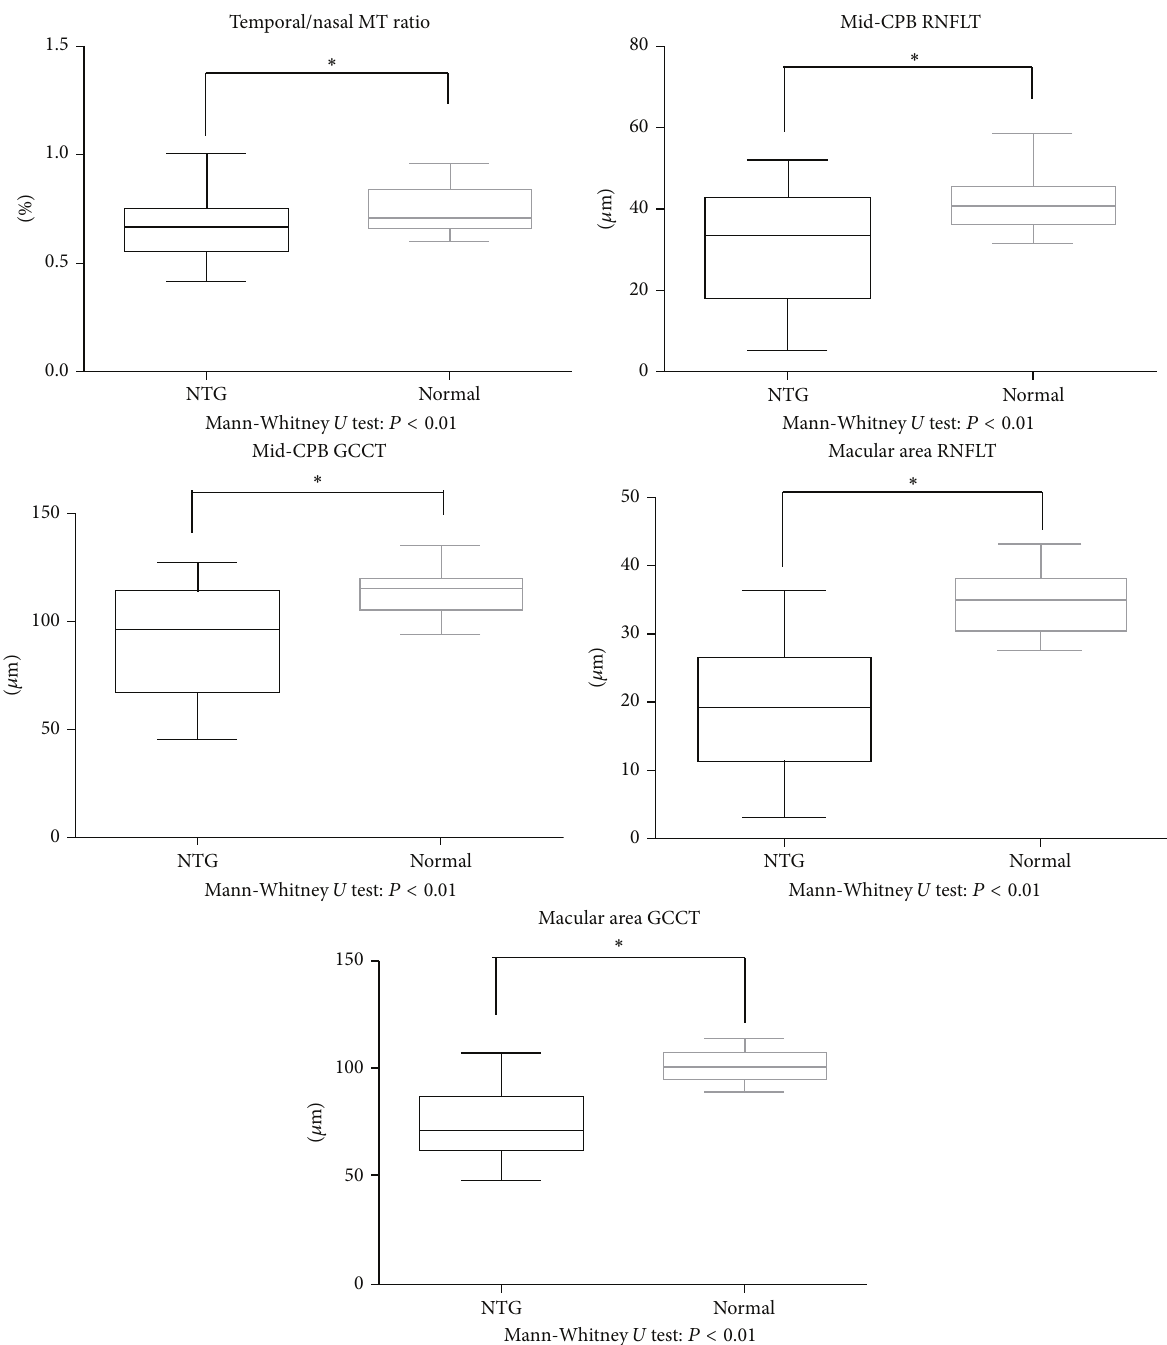
Figure 1: Comparison of T/N MT, RNFLT, and GCCT in NTG patients and normal subjects. T/N MT, mid-CPB RNFLT, mid-CPB GCCT, macular RNFLT, and macular GCCT were decreased in NTG patients compared to normal subjects (all 𝑃 < 0.01 ).